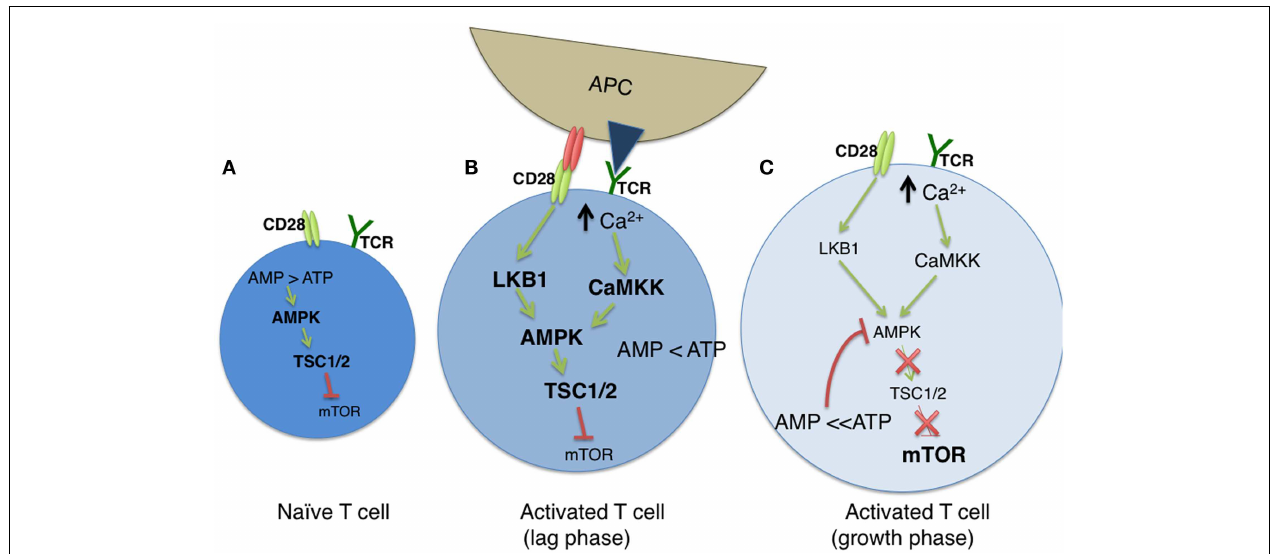
During a lag phase that precedesT cell clonal expansion, LKB1 and CaMKK (itself induced by high cytosolic Ca 2 + levels) promote AMPK function despite reduced AMP levels, and mTOR activity remains low viaTSC1/2 mediated inhibition. (C) AsT cells exit the lag phase, heightened levels of ATP block AMPK activity, which results in the loss ofTSC1/2 activity.This allows for sustained mTOR function, and subsequent mTOR driven clonal expansion and cell